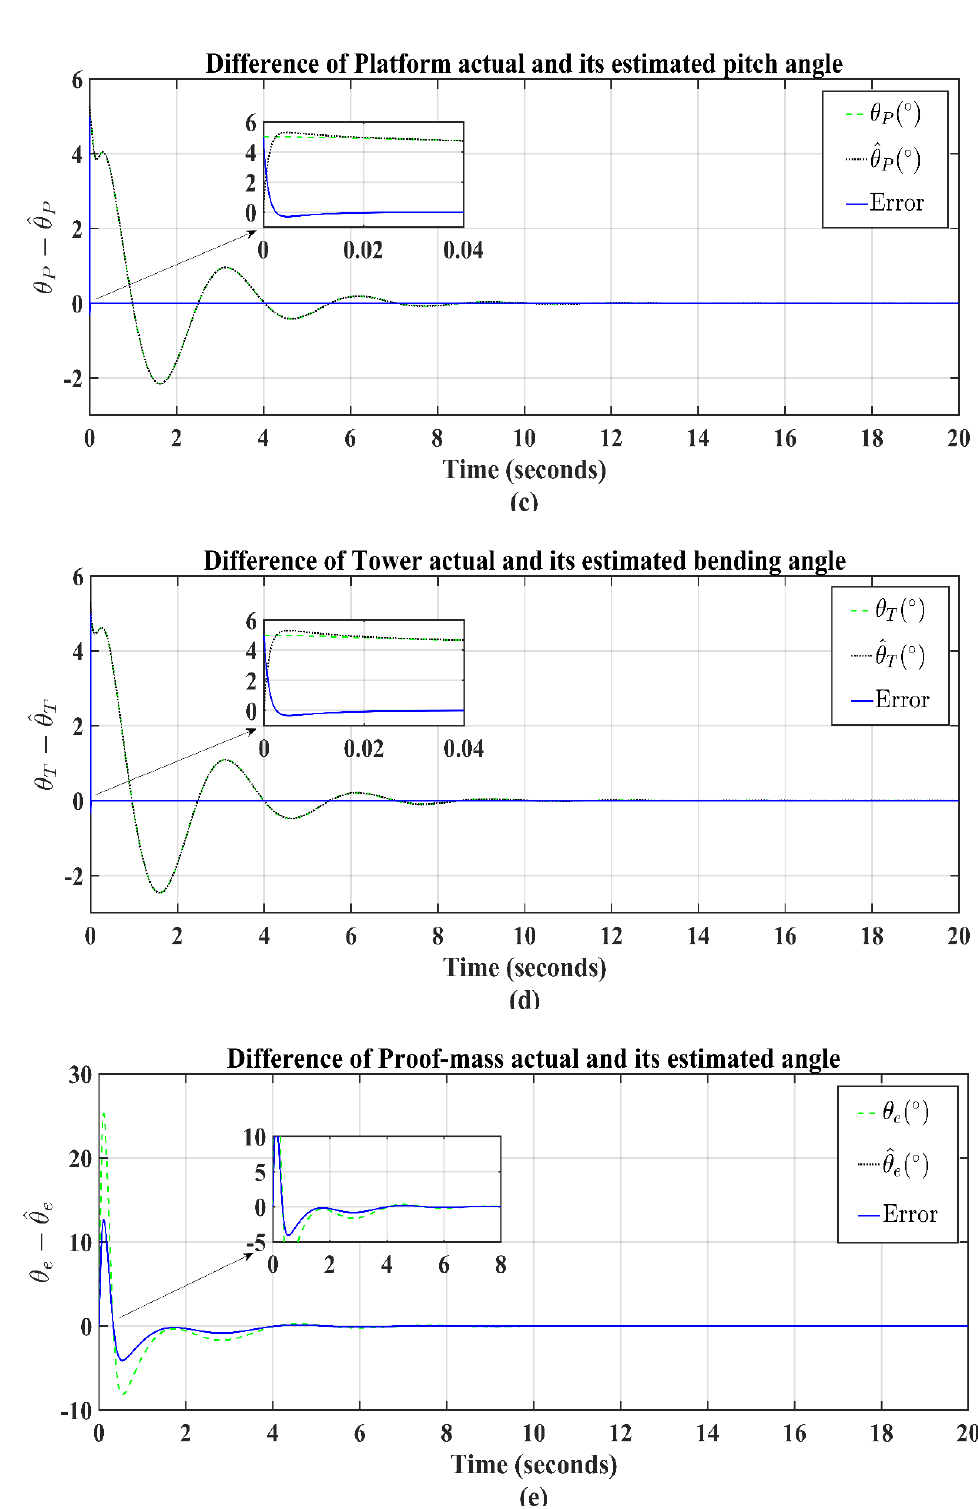
Figure 7. Simulation results of the controlled barge − type 5DOF TORA − based OFWT for the actual states (green) and their estimated states (black), and corresponding error (blue color): ( a ) Difference between platform surge and its estimated displacement, ( b ) Difference between platform heave and its estimated displacement, ( c ) Difference between platform’s actual and its estimated pitch angle, ( d ) Difference between tower’s actual and its estimated bending angle, ( e ) Difference between proof mass actual and its estimated